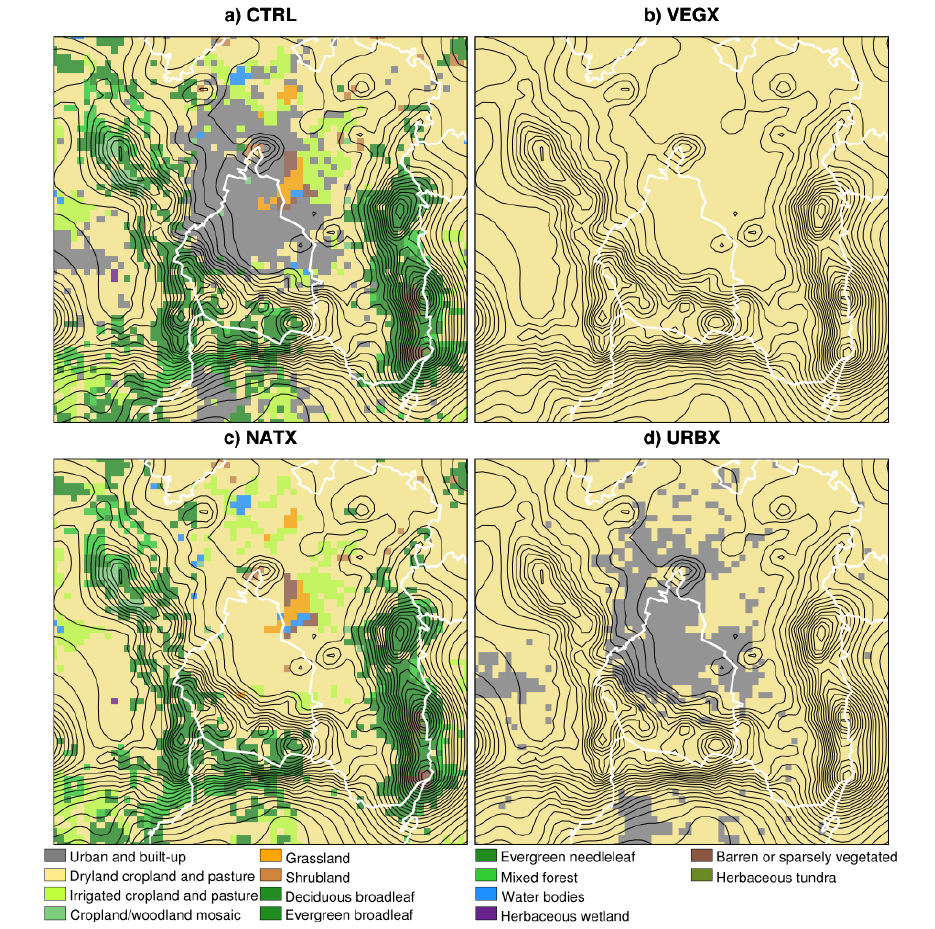
Figure 2. Land use land cover for the four experiments: ( a ) all LULC categories from the new INEGI series, control experiment (CTRL), ( b ) cropland dryland and pasture LULC category only experiment (VEGX), ( c ) same LULC as CTRL but with urban and built-up categories replaced by the cropland, dryland and pasture category, and ( d ) same LULC as in the VEGX experiment but with urban and built-up superimposed